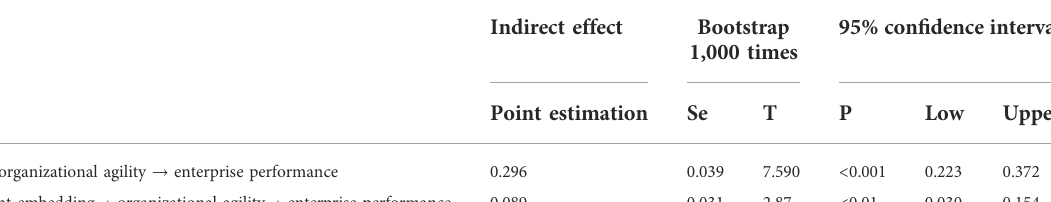
TABLE 4 Test of the mediating effect of organizational agility.